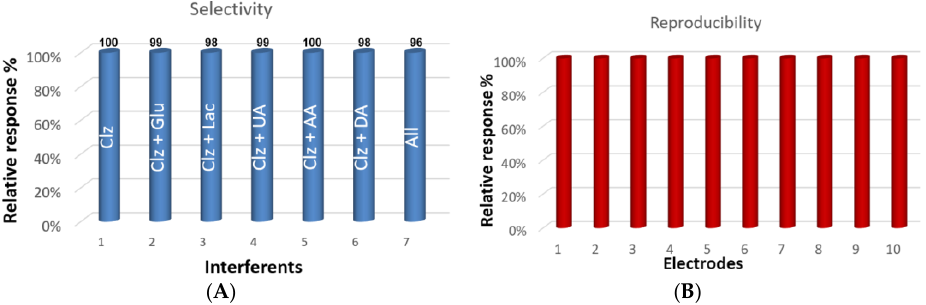
Figure 5. ( A ) Selective CV response of modified CTS towards Clz in the presence of common various interfering species (AA: ascorbic acid, Lac: lactic acid, Glu: glucose, UA: uric acid); ( B ) reproducibility of modified CTS containing 1 µM Clz at ten different electrodes (10 mM PBS, pH 7.4).